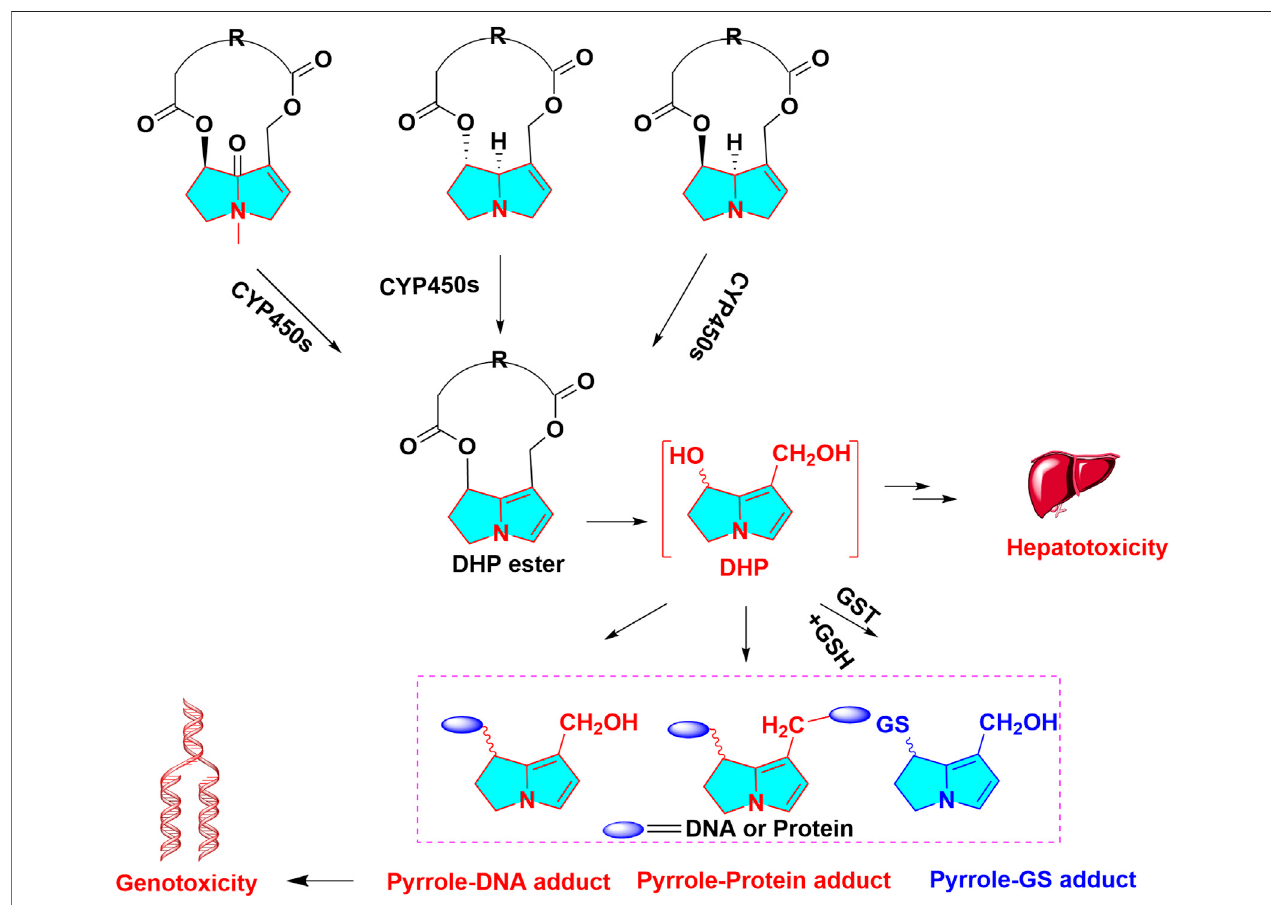
FIGURE 1 | Metabolic activation in hepatotoxicity of PAs, otonecine-type PA, heliotridine-type PA and retronecine-type PA are oxidized to dehydro PAs, then dehydro PAs are hydrolyzed to DHP, reactive metabolites can capture GSH, protein, DNA, forming GSH, protein, DNA adduct, respectively.